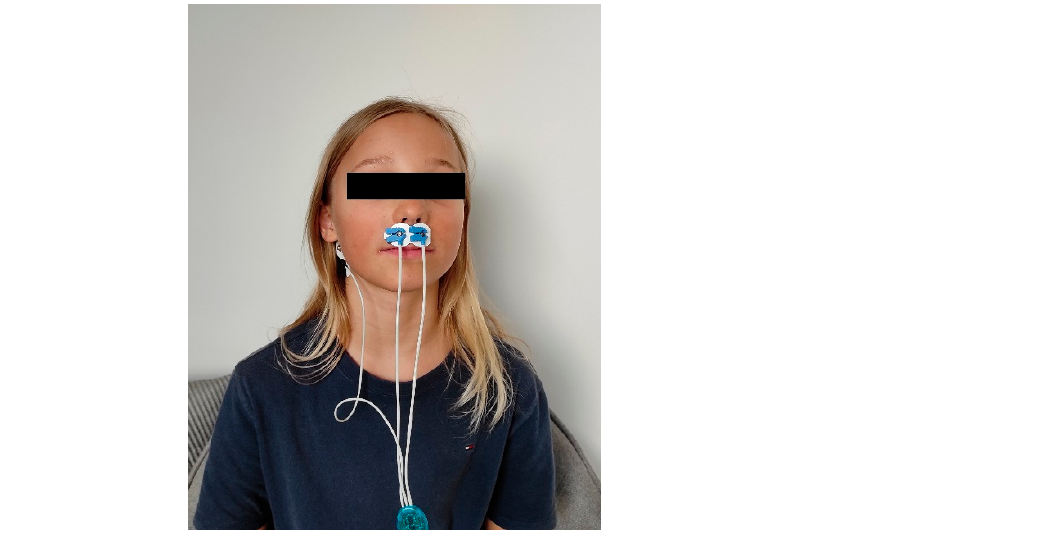
Figure 1. Location of surface electrodes (Noraxon Dual Electrode, Noraxon, USA) during EMG examination of the upper lip.